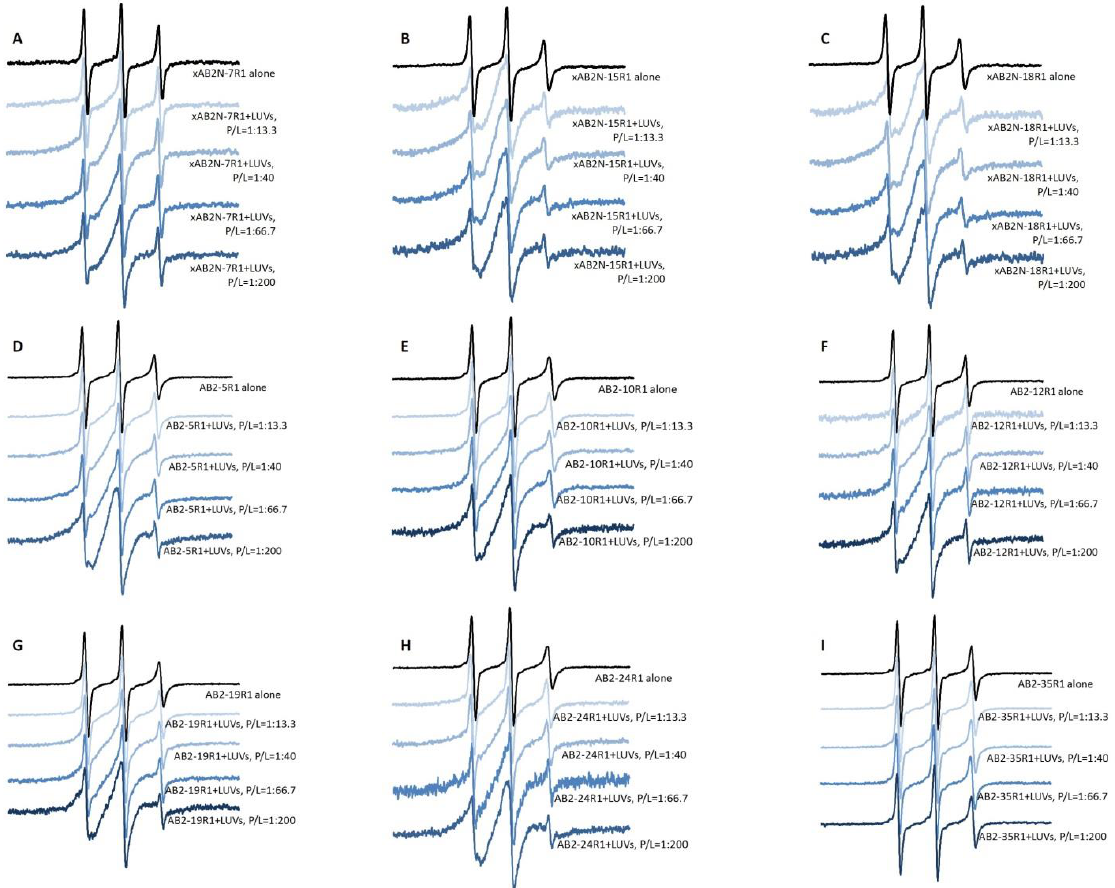
Figure 1. Representative EPR spectra of 15 µ M peptide with LUVs at indicated peptide-to-phospholipid molar ratios. All EPR spectra, in this and subsequent figures, are renormalized to the same amplitude. xAB2N spin-labeled at positions ( A ) 7, ( B ) 15, and ( C ) 18 and AB2 spin-labeled at positions ( D ) 5, ( E ) 10, ( F ) 12, ( G ) 19, ( H ) 24, and ( I )